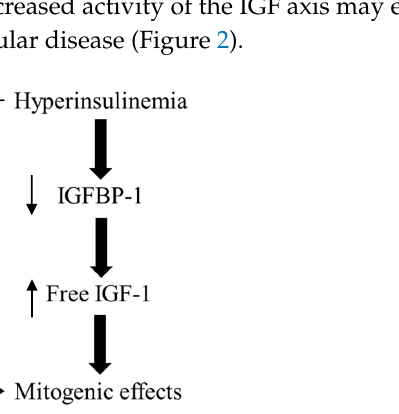
Figure 2. Insulin resistance/hyperinsulinism mitogenic effects. The hyperinsulinemia compensatory to insulin resistance, appears to exert its mitogenic effects directly by acting on its own receptors or indirectly, by reducing the production of IGFBP-1 in the liver and thus increasing the bioavailability of free IGF-1. IGFBP-1: insulin-like growth factor-binding protein 1.